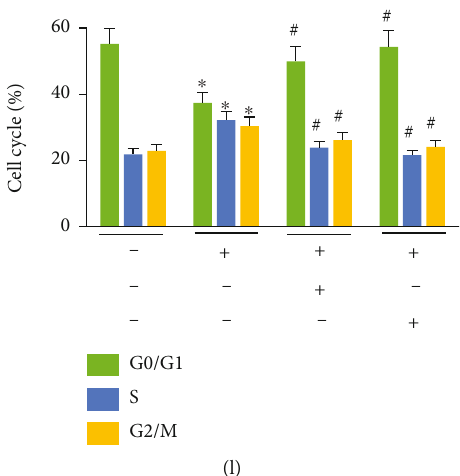
Figure 4: miR-181a-5p modulates osteosarcoma progression via PTEN-AKT pathway in vitro. (a and b) Representative western blot images and the statistical analysis of AKT and PTEN ( n = 6 ). (c) Relative PTEN mRNA levels in osteosarcoma cells treated with miR-181a-5p mimic or inhibitor ( n = 6 ). (d) Putative binding site of between miR-181a-5p and 3 ′ -UTR of PTEN. (e) Relative luciferase activity in HEK293T cells ( n = 6 ). (f) Correlation between miR-181a-5p level and PTEN expression in human osteosarcoma tissues ( n = 20 ). (g) Representative western blot images and the statistical analysis of PTEN ( n = 6 ). (h and i) Cell viability and colony numbers in osteosarcoma cells ( n = 6 ). (j and k) Gap size and invasive cells in osteosarcoma cells ( n = 6 ). (l) Cell cycle distribution in di ff erent phases ( n = 5 ). All data are presented as the mean ± SD , ∗ P < 0 : 05 versus the matched group. (l) ∗ P < 0 : 05 versus control group, # P < 0 : 05 versus miR-181a-5p mimic-treated osteosarcoma